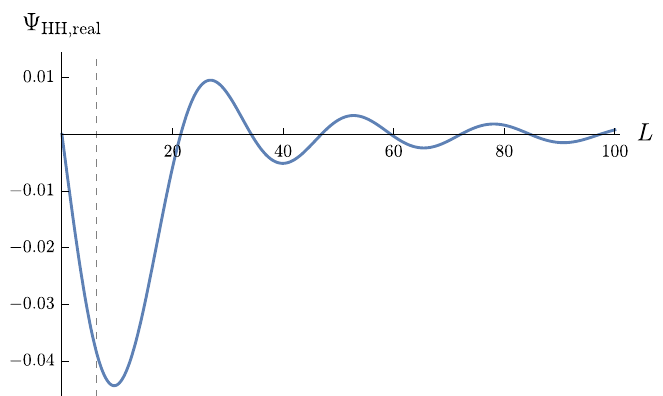
= 1 / 4. The vertical dashed line Figure 4: Plot of the wavefuntion Ψ for φ b HH,real indicates the location, L = 2 π , where the expanding branch Ψ + of the wavefunction (102) diverges, but Ψ remains HH,real